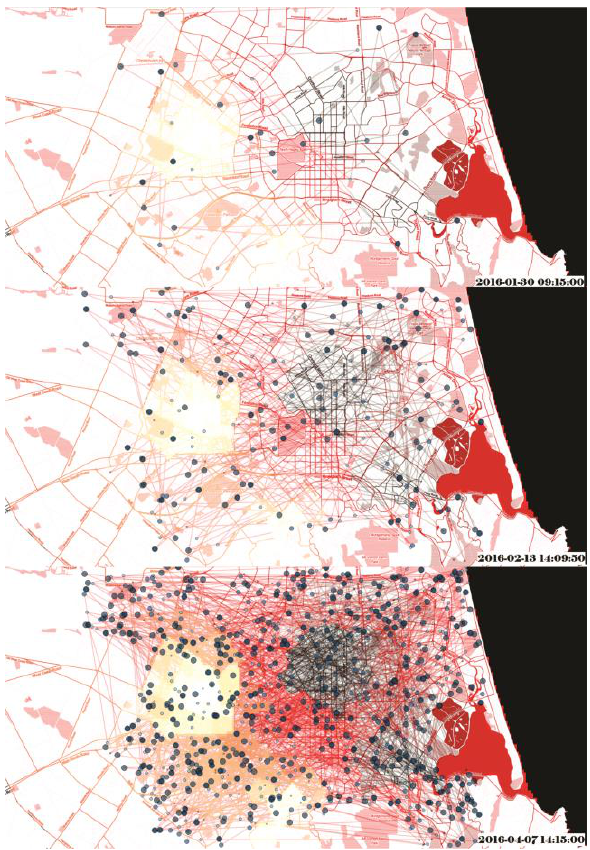
Figure 7. Time slices of volunteers’ flowlines combined with PM 10 exposure surface and the usage of their medical